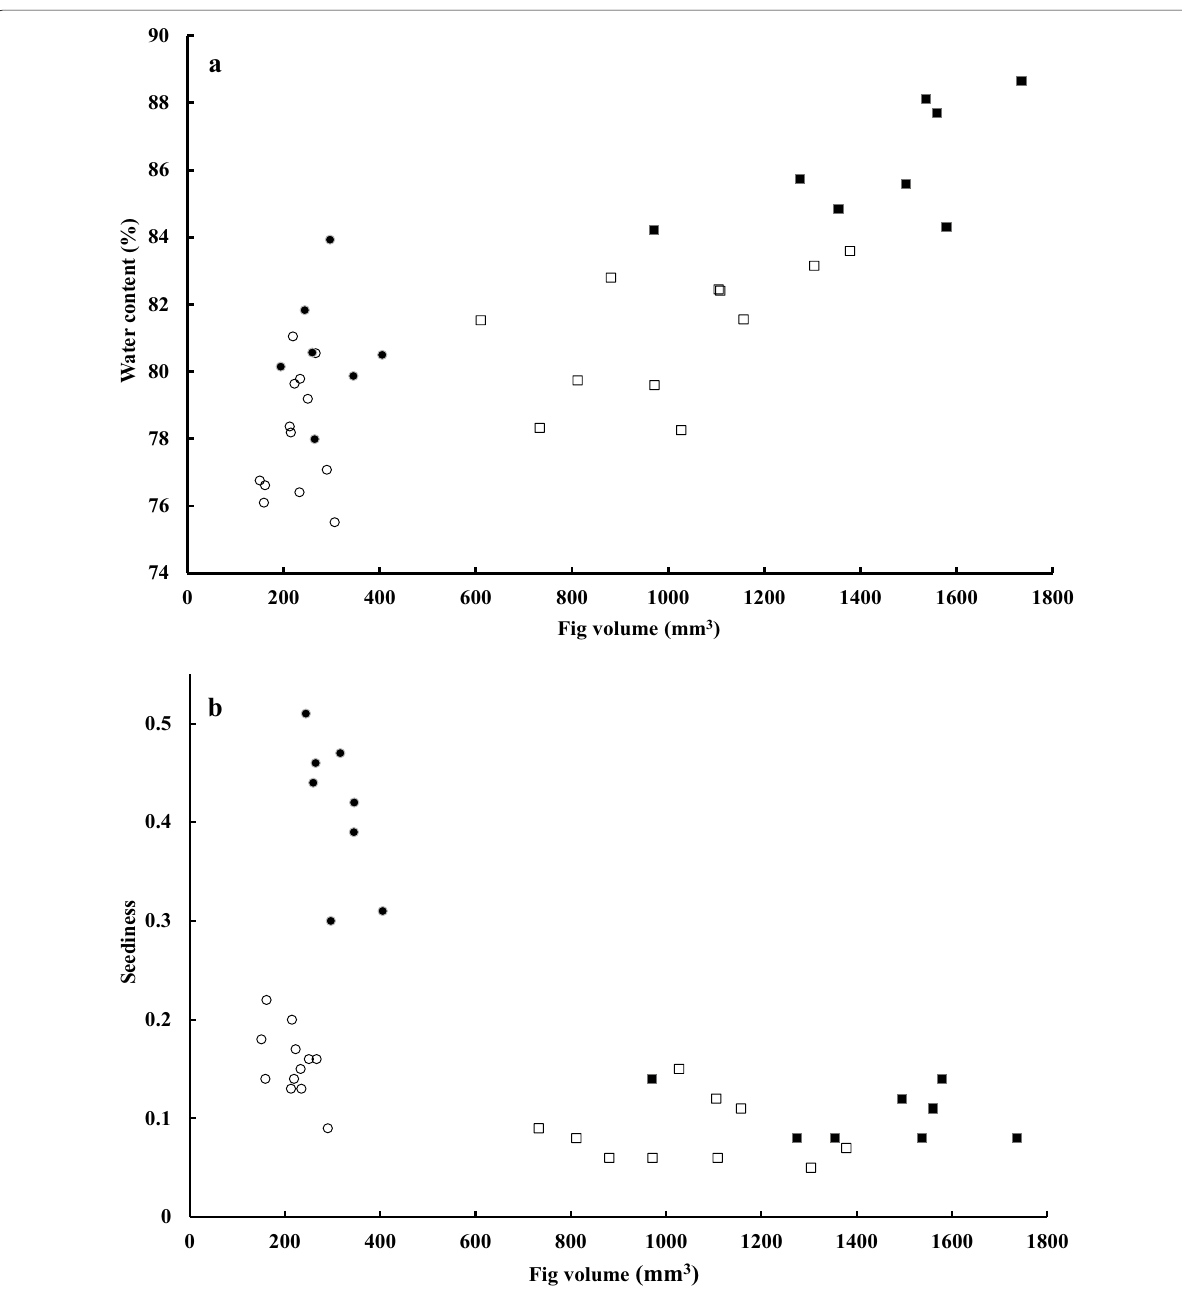
Fig. 2 The correlation between a water contents, and b seediness, with fig volume sizes in monoecious (open circle: F. caulocarpa ; open square: F. subpisocarpa ) and dioecious (filled circle: F. ampelas ; filled square: F.irisana ) species assessed in HTBC,